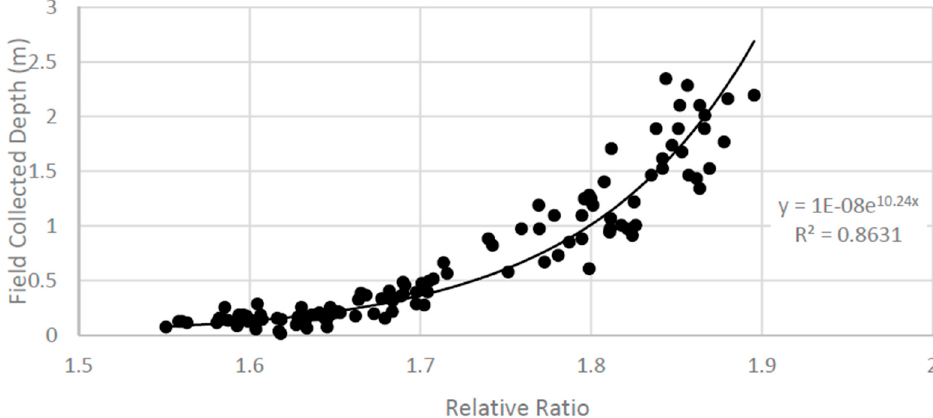
Figure 7. Relative bathymetry ratio ( x -axis) versus measured depth ( y -axis). This equation was used to calculate bathymetry for all of the sand and water areas.